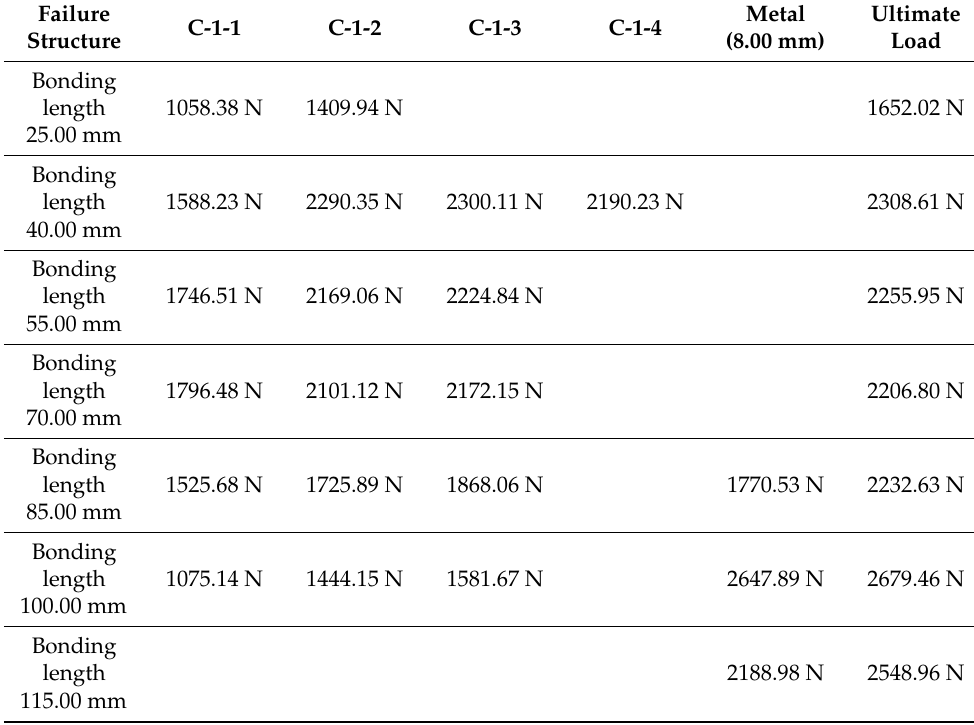
Table 5. Simulated failure mode versus compressive load.